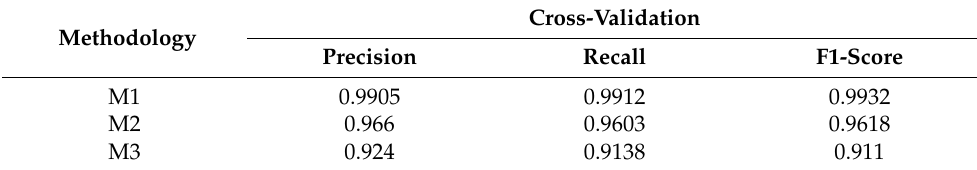
Table 4. Comparison of the methodologies on Pattern A. Methodology